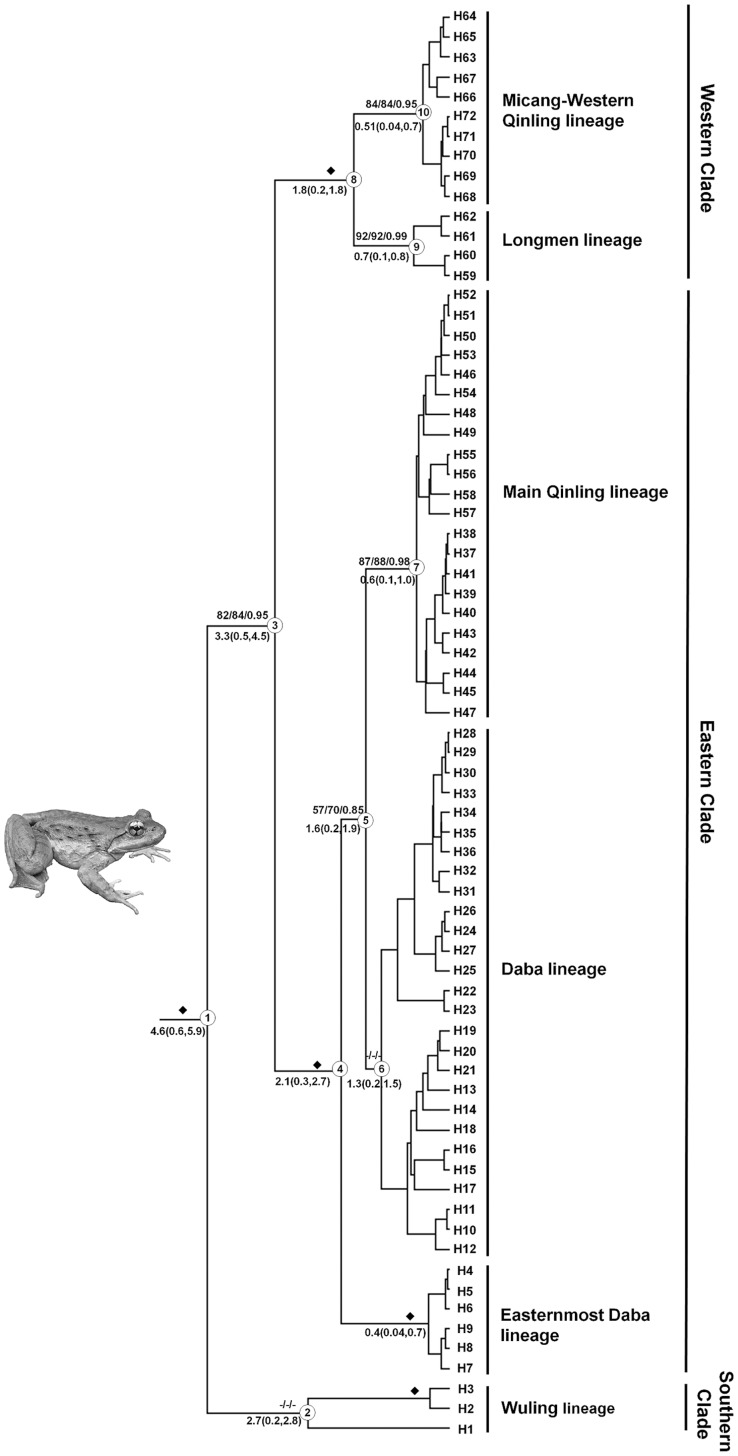
Bayesian tree for the 72 sampled haplotypes of Feirana quadranus based on ND2 gene sequences.The bootstrap values calculated by Maximum Parsimony and Maximum Likelihood analyses and the Bayesian posterior probabilities from Bayesian analyses are presented above the main branches; the diamonds on branches mean that all support values are greater than 95%. The estimated divergence time (Ma, mean and 95% CI’s) for major nodes is below the branches. Ten major nodes (1–10) are indicated on the tree. Haplotypes (H1–H72) were given in Table 1.